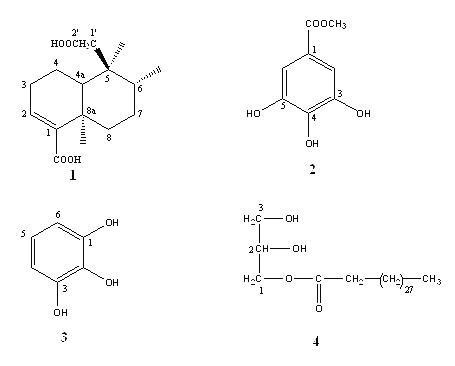
Chemical structures of compounds isolated from Entada abyssinica ethyl acetate fraction. 1:(5S,6R,8aR)-5-(carboxymethyl)-3,4,4a,5,6,7,8,8a-octahydro-5,6,8a-Trimethylnaphthalenecarboxylic acid; 2: methyl 3,4,5-trihydroxybenzoate; 3: benzene-1,2,3-triol; 4: 2,3-dihydroxypropyltriacontanoate.